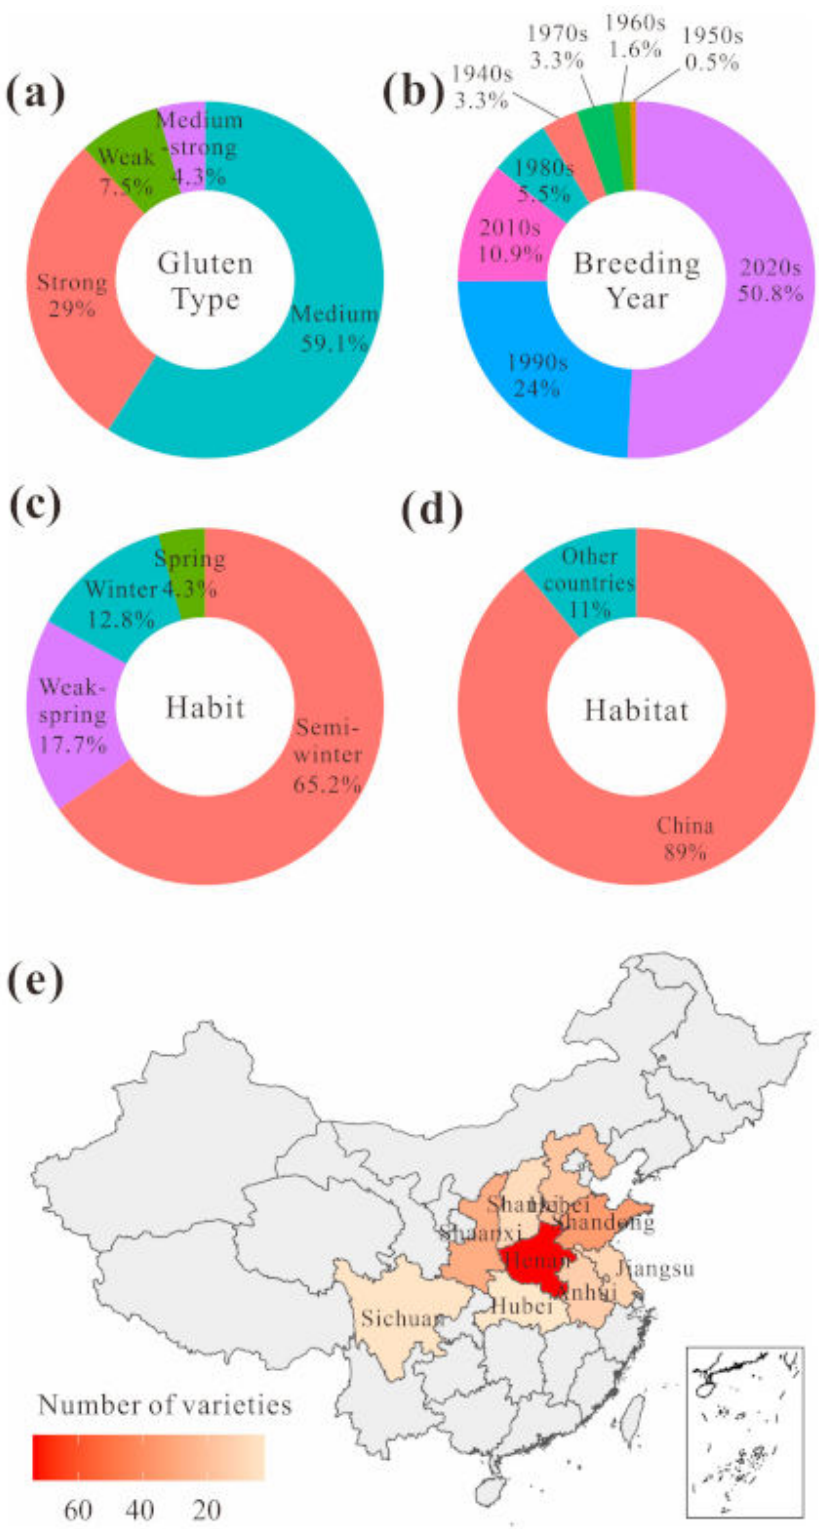
Figure 1. Distribution of tested varieties in terms of gluten type ( a ), breeding year ( b ), habit ( c ), and habitat ( d ), particularly among nine provinces in China ( e